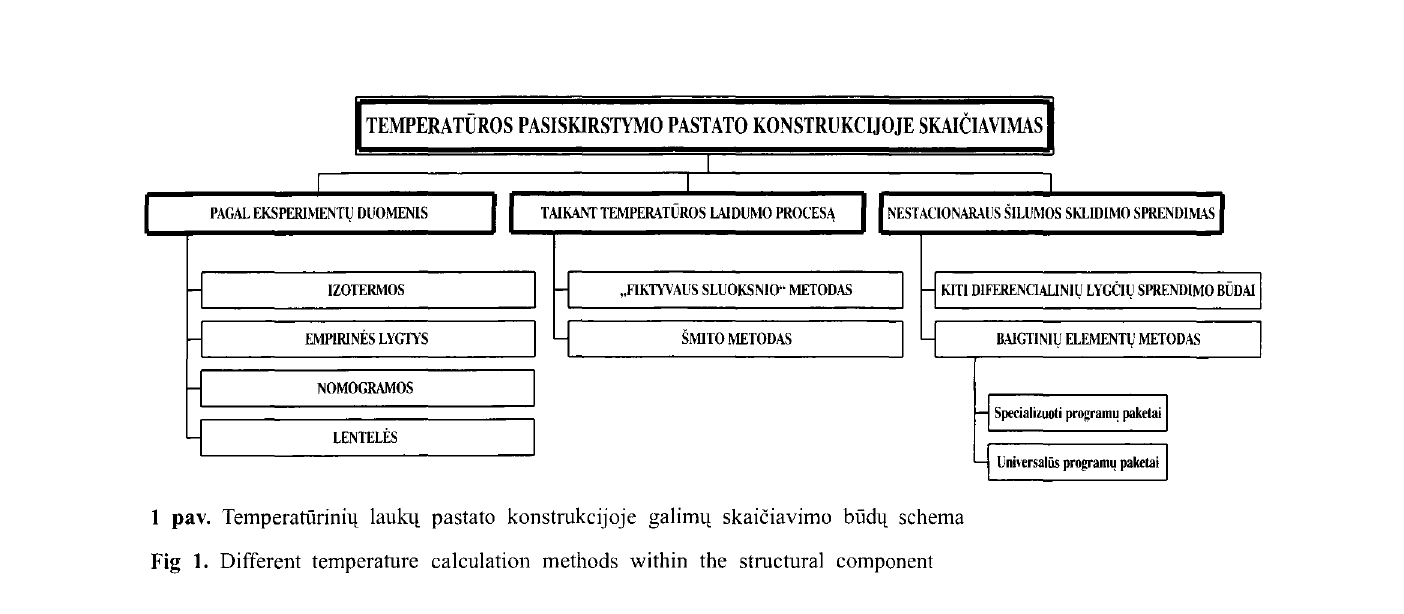
- neivertinama atitvarines konstrukcijos defonna cija, sudegimas, apanglejimas bei terminis suirimas [II, 12, 16-19]. Vykstant gaisrui konstrukcijose del aukstos temperaturos atsiranda dideles deformacijos, del kuri4 atitvaros sandurose atsiveria plysiai, taigi gaisras gali plisti toliau ir konstrukcija nebeatitinka jai keliam4 rei kalaviml!. Plysiai gali atsirasti konstrukcijai yrant, per degant, trupant ir pan.; - atitvara nagrinejama kaip plokscia is vienos pu ses kaitinama